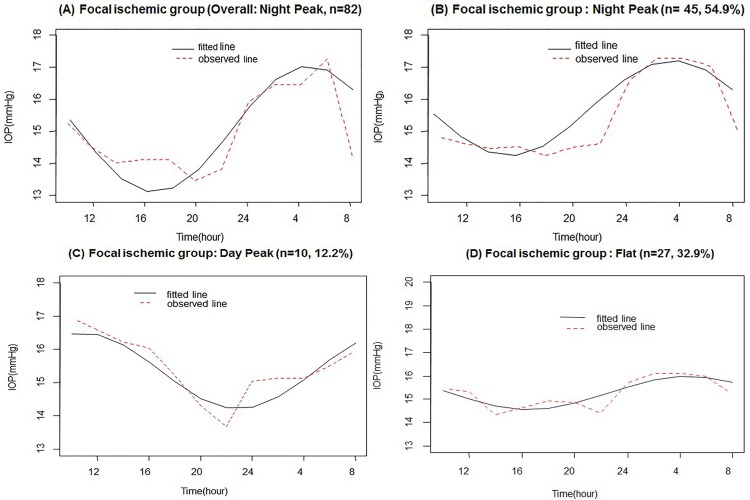
Average 24-h of habitual-position IOP rhythms in all patients (A) and in three subgroups of patients (B, C, and D) based on the cosinor model in the focal ischemic (FI) group.